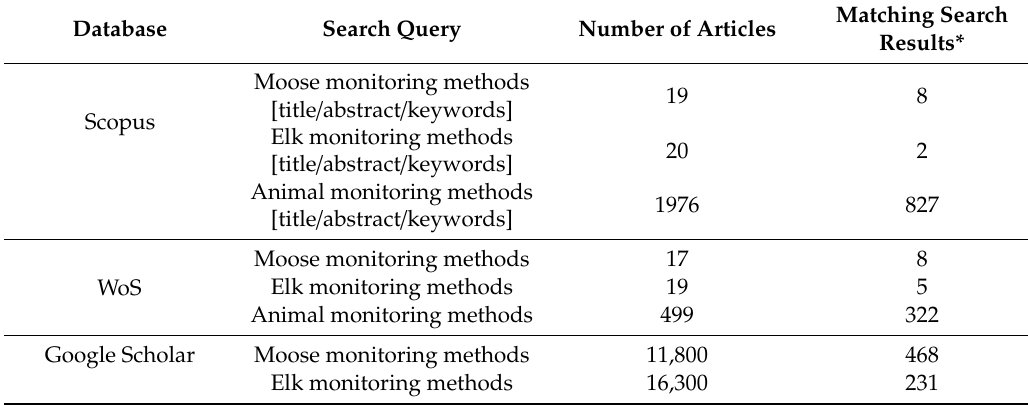
Table 2. Strategies for searching the literature sources for the